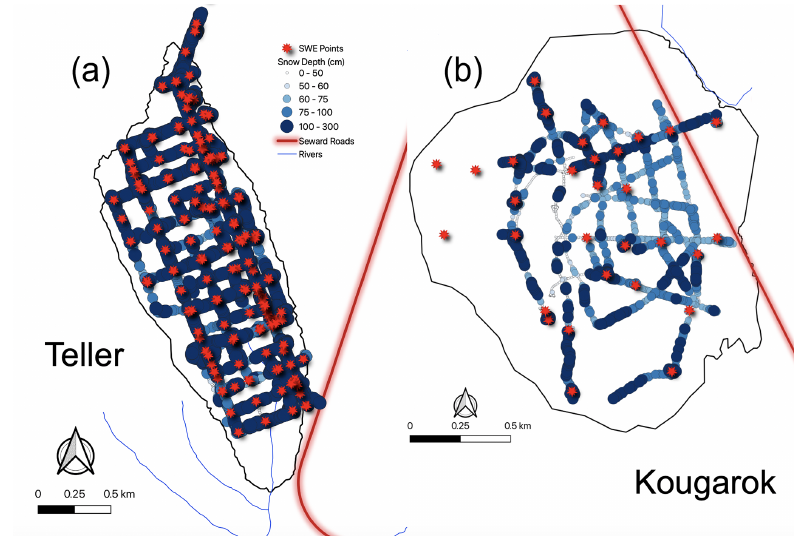
Figure 2. Measured snow depth (cm) and snow density (SWE points) at (a) the Teller watershed (2017–2019) and (b) the Kougarok Hillslope (2018). Table 2. Teller and Kougarok Hillslope snow depth and density observations and SWE observations and estimates. The coefficient of variation (CV) of the observed variables are in parentheses following the average